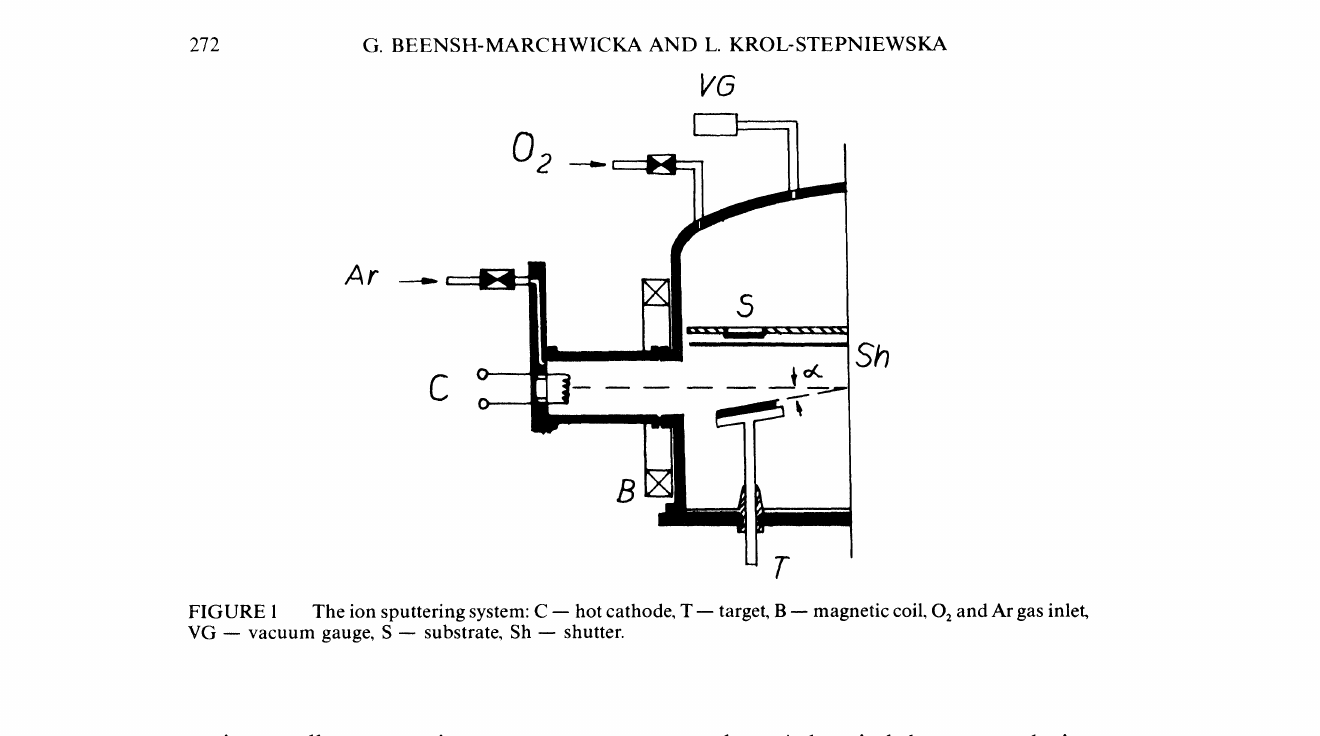
FIGURE The ion sputtering system: C hot cathode, T target, B magnetic coil, Oz and Ar gas inlet, VG vacuum gauge, S substrate, Sh